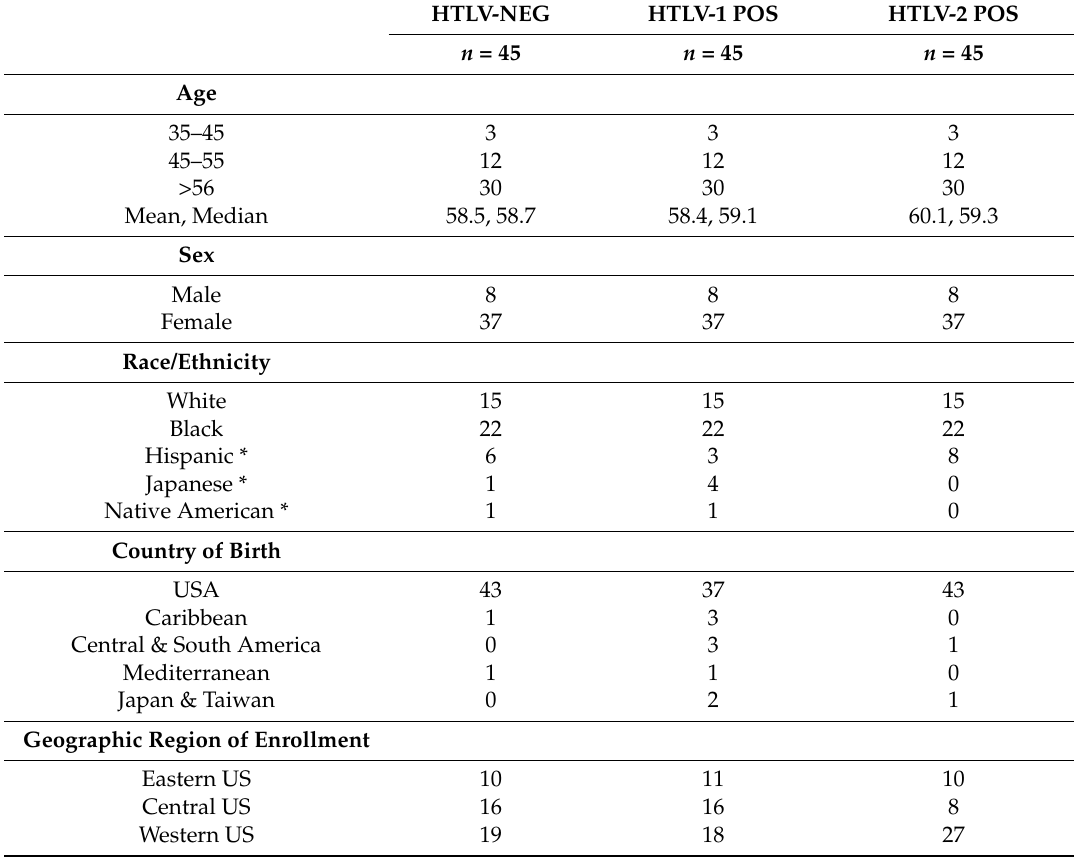
Table 1. Characteristics of the study